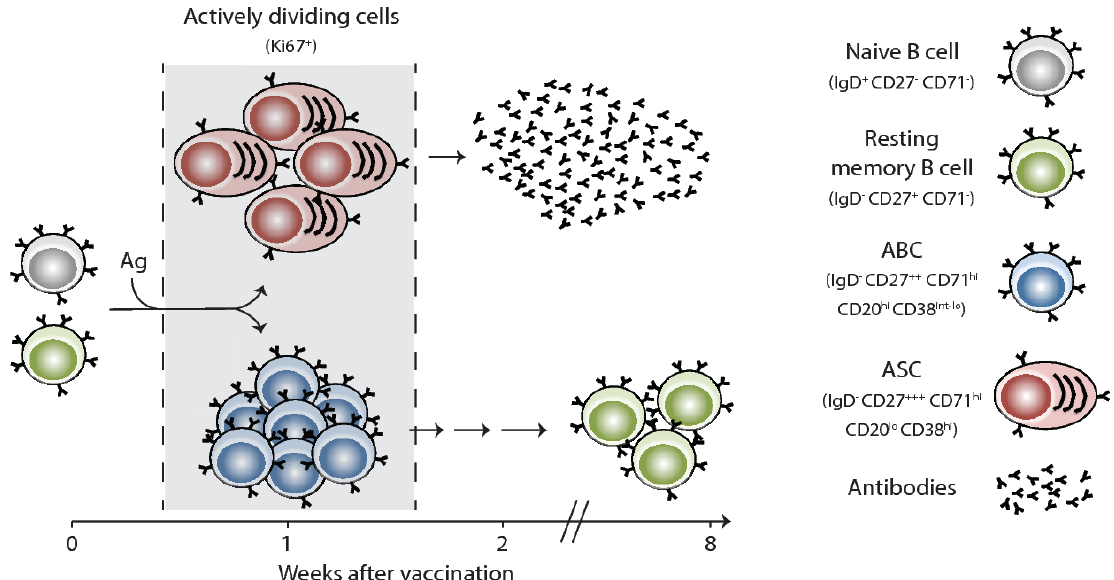
Figure 1. Human B cell responses to seasonal influenza vaccination in humans. A graphical model illustrating the phenotype and kinetics of B cell responses to inactivated seasonal influenza vaccines as detected in human peripheral blood. Ki67 is a nuclear proliferation marker; ABC is activated B cells; ASC is antibody secreting cells or plasmablasts.